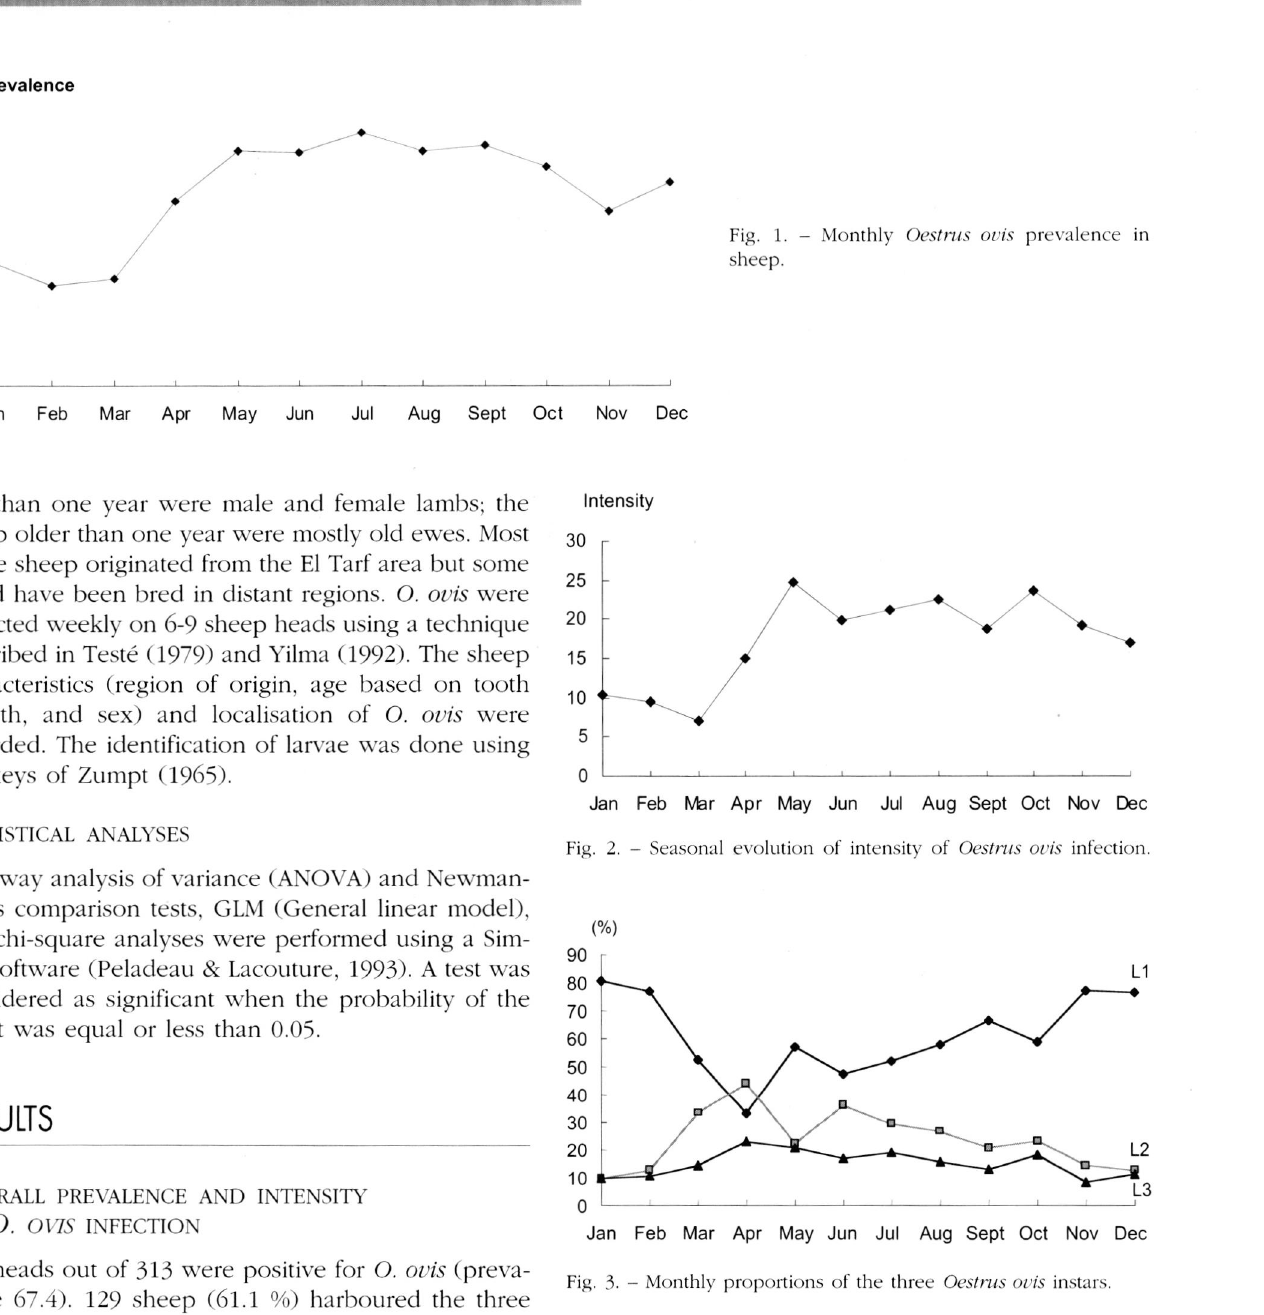
Fig. 3. - Monthly proportions of the three Oestrus oris